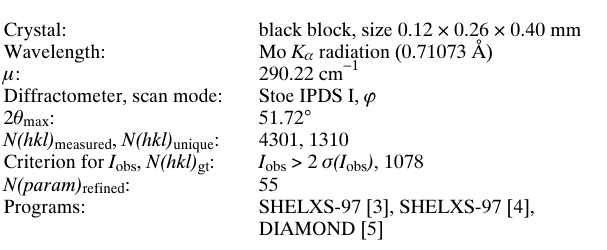
Table 1. Data collection and handling.